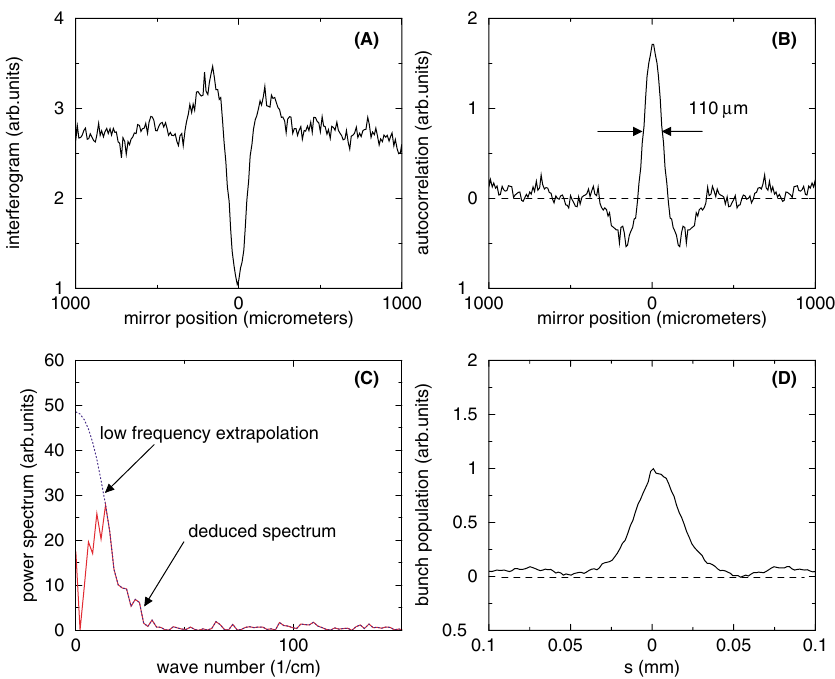
FIG. 6. (Color) Example of bunch length measurement. (a) Raw data obtained from the Michelson polarizing interferometer; (b) deduced autocorrelation from the interferogram; (c) power spectrum obtained by Fourier transforming the autocorrelation; (d) charge density longitudinal distribution obtained by applying the Kroenig-Kramer relations on the power spectrum to recover the (missing) phase